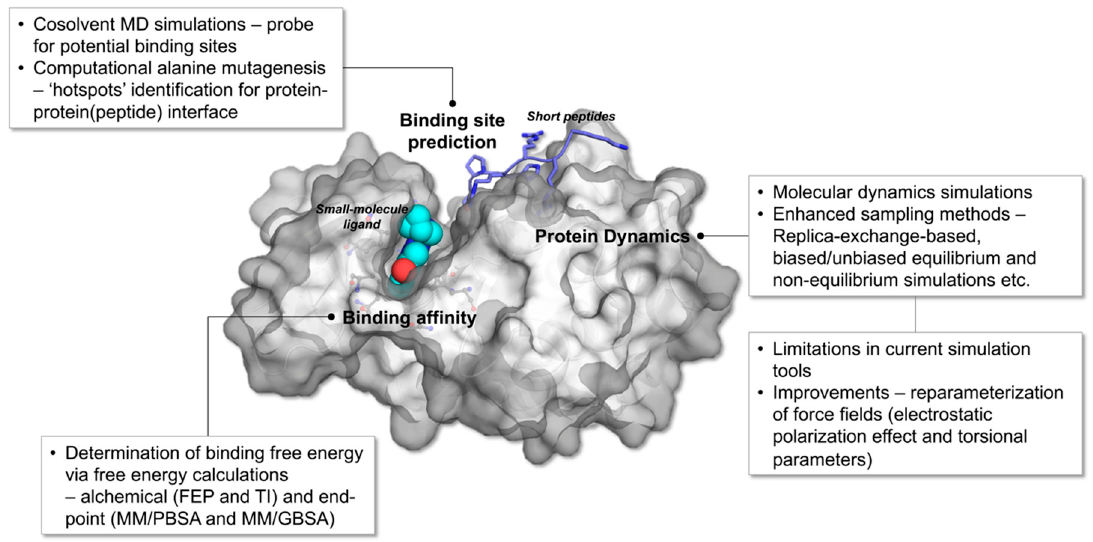
Figure 1. Overview of MD simulation and enhanced sampling methods utilized in the study of protein-protein (peptide) and protein-ligand complexes. The figure is constructed using the crystal structure of human PIM1 kinase in complexed with imidazopyridazin inhibitor and substrate peptide (PDB id: 2C3I).